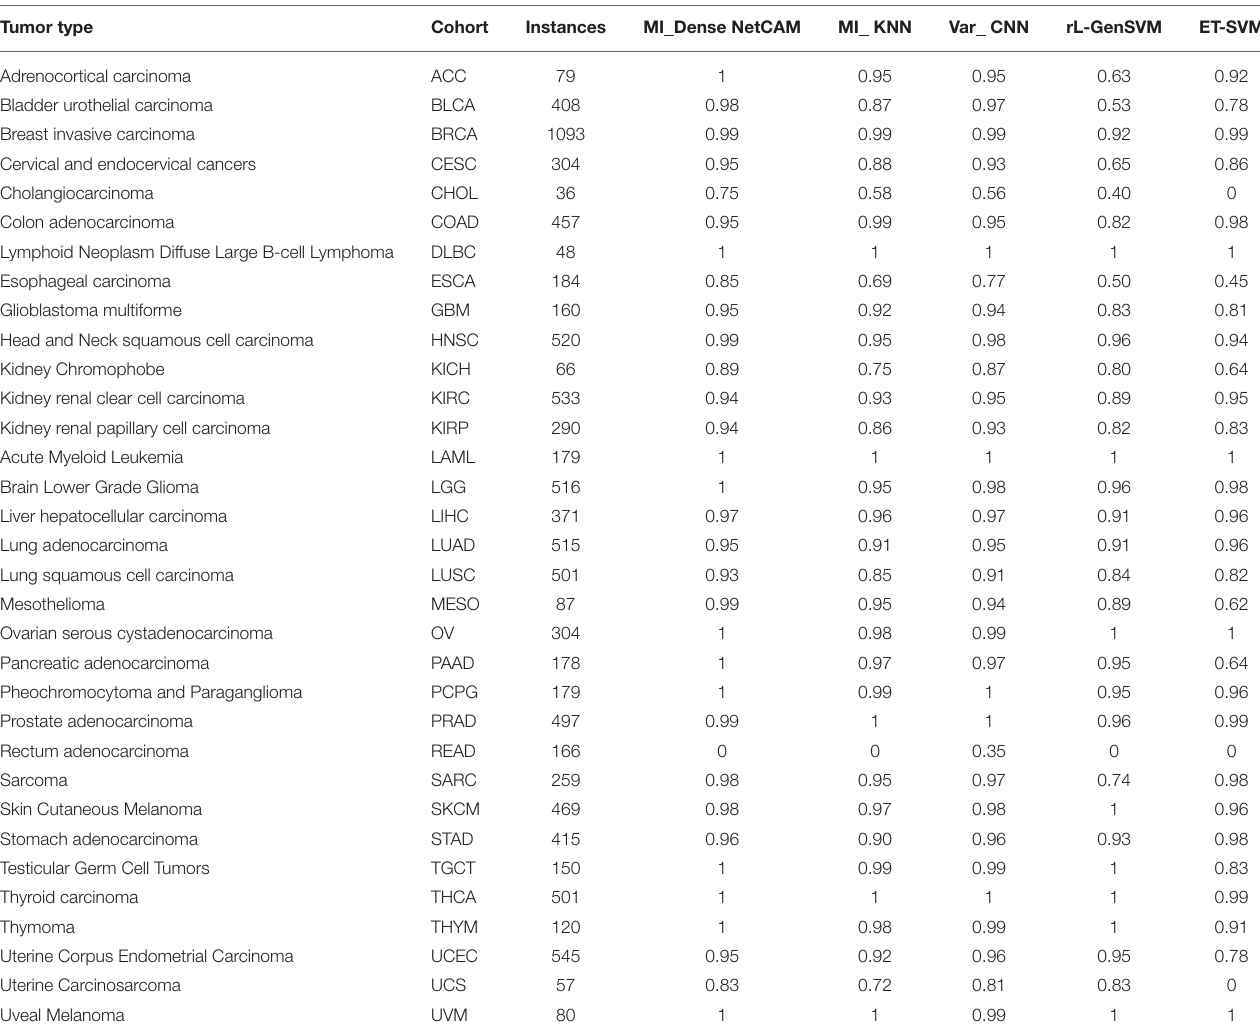
TABLE 3 | Benchmark